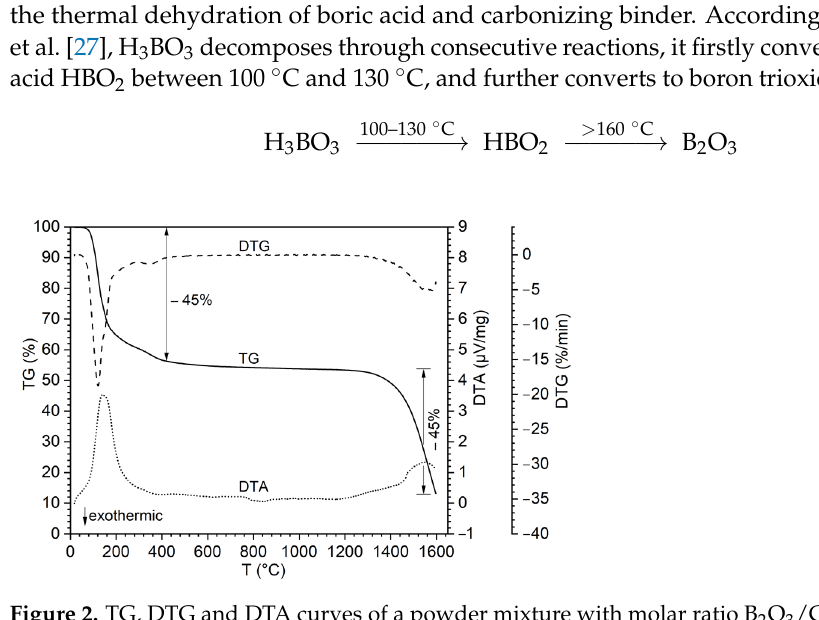
Figure 2. TG, DTG and DTA curves of a powder mixture with molar ratio B 2 O 3 /C = 2:1.